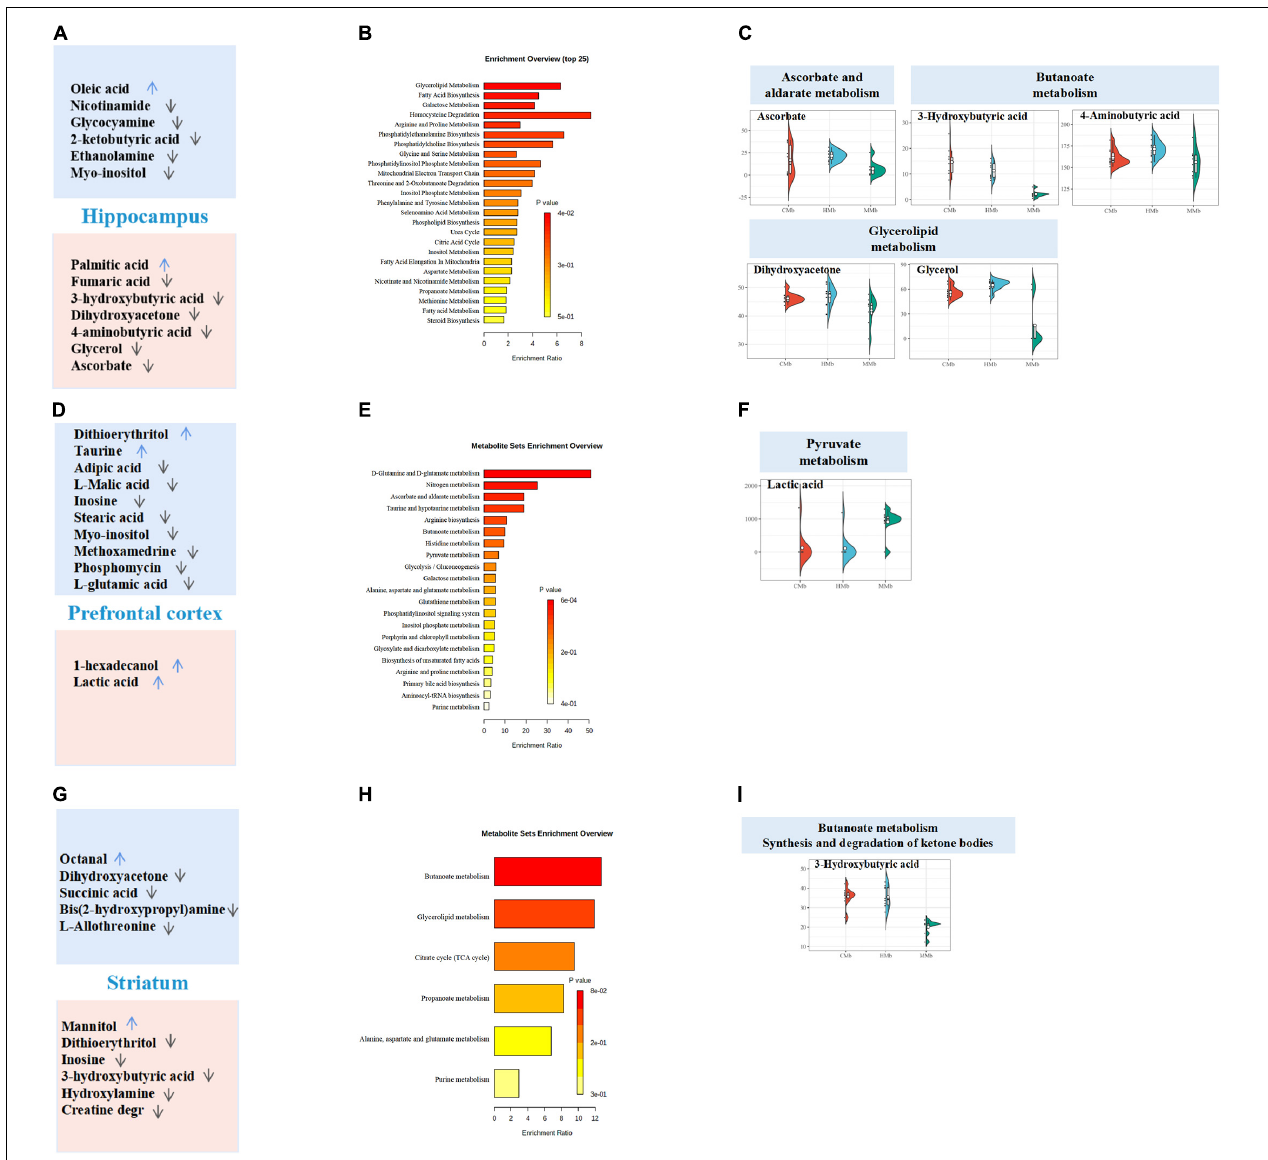
FIGURE 5 | Reversed metabolites enriched in differential metabolic pathways in the three emotional brain. (A,D,G) Total differential metabolites between HMb and MMb group in hippocampus, prefrontal cortex, and striatum were, respectively, presented in the boxes. Reversed metabolites among differential metabolites were in the red box, and the remaining differential metabolic substances were in the blue box. The arrow direction indicated more up-regulation or down-regulation of metabolite expression in MMb group compared with HMb group. (B,E,H) Enrichment overview of differential metabolites in hippocampus, prefrontal cortex, and striatum. (C) Five (71.4%) reversed metabolites were involved in the top three metabolic pathways of the differential metabolic substances in hippocampus. Ascorbate was involved in ascorbate and aldarate metabolism, 4-aminobutyric acid and 3-hydroxybutyric acid were involved in butanoate metabolism, and dihydroxy acetone and glycerol were involved in glycerolipid metabolism. (F) Of the top three metabolic pathways of differential metabolic substances in prefrontal cortex, only lactic acid (50.0%) was involved in pyruvate metabolism. None of the reversed metabolites were included in glyoxylate and dicarboxylate metabolism or nitrogen metabolism. (I) In striatum, three-hydroxybutyric (16.7%) acid was involved in both butanoate metabolism and the synthesis and degradation of ketone bodies, which were in the top three metabolic pathways of differential metabolic substances. None of the reversed metabolites were involved in glycerolipid